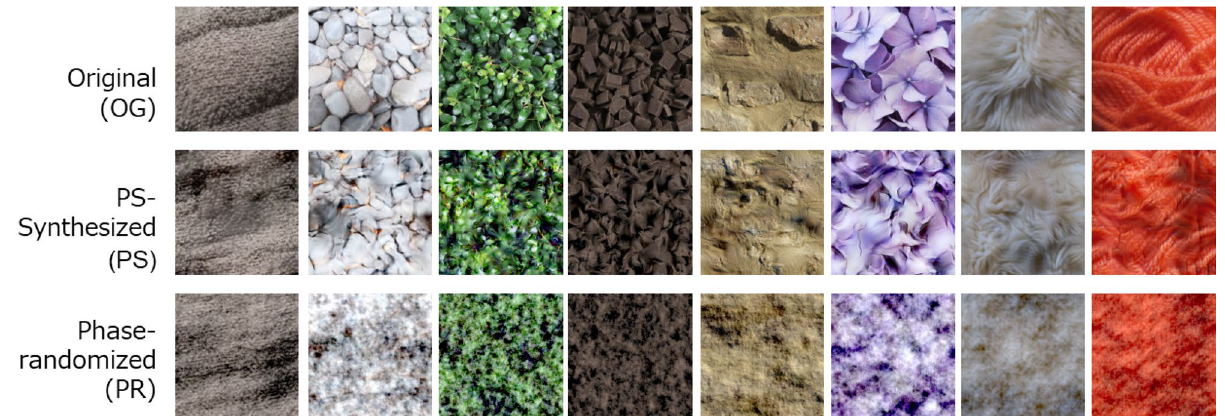
Figure 6. Examples of synthetic images generated from the originals. The top row shows the original image (OG). The middle row shows an image synthesized based on the Portilla–Simoncelli model (PS). The bottom row shows phase-randomized images